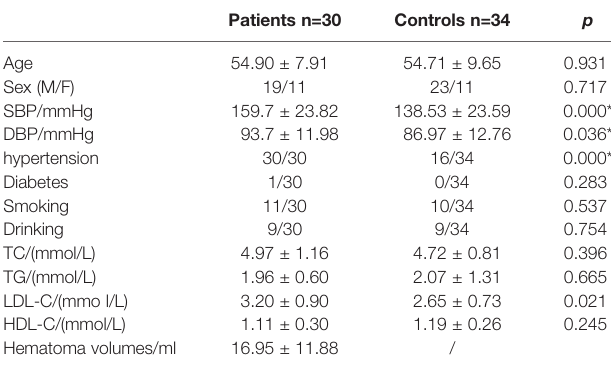
TABLE 1 | Demographic and clinical characteristics of ICH and control group.